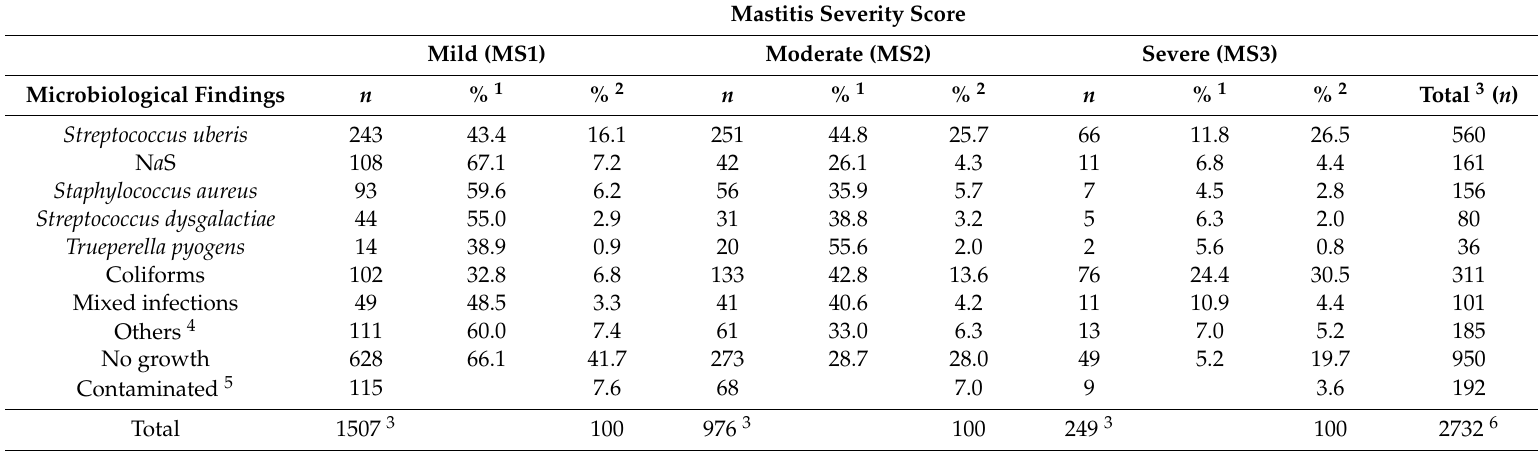
1 : Proportion of cases of all cases caused by the pathogen group. 2 : Proportion of cases of all cases of the respective MS. 3 : Number of cases per pathogen group with MS. 4 : Prototheca spp., Bacillus spp., Enterococcus spp., yeast, Pseudomonas spp., Corynebacterium spp., other streptococci. 5 : More than two di ff erent pathogens were detected in one sample. 6 : Number of cases